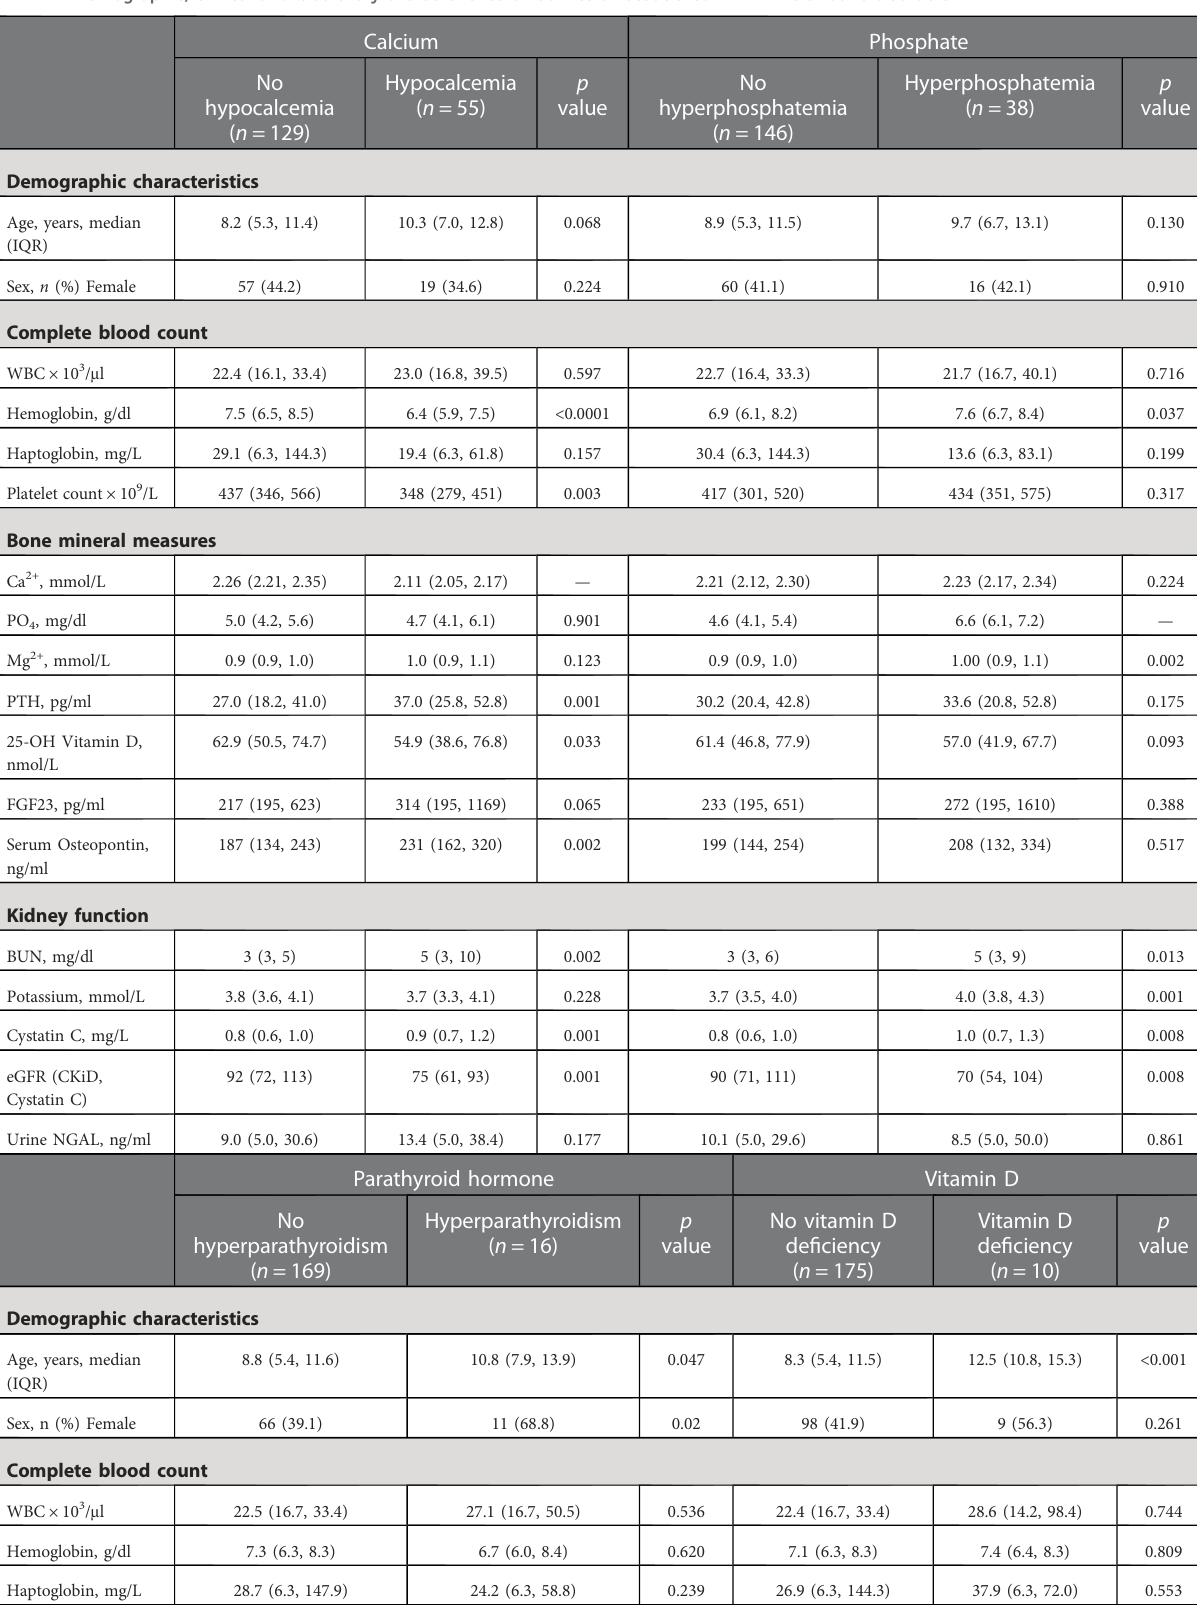
TABLE 2 Demographic, clinical and laboratory characteristics on admission associated with mineral bone